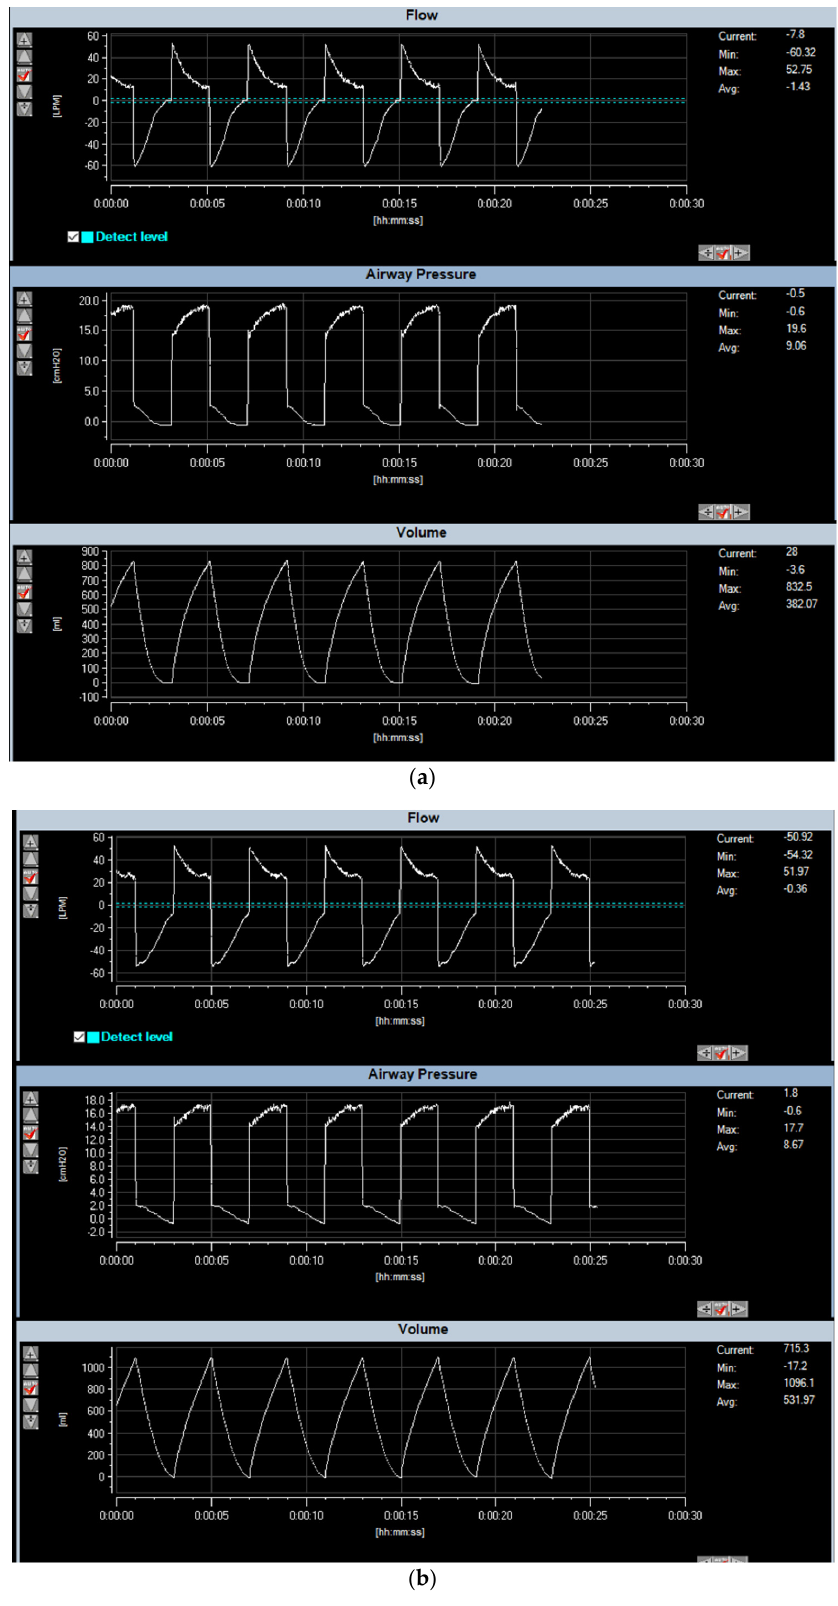
Figure 20. Performance test using VT Plus Hi Flow Ventilator analyzer and SmartLung 2000: ( a ) lung resistance of 20 mbar/L/s and lung compliance of 0.060 L/mbar; ( b ) lung resistance of 20 mbar/L/s and lung compliance of 0.075 L/mbar.